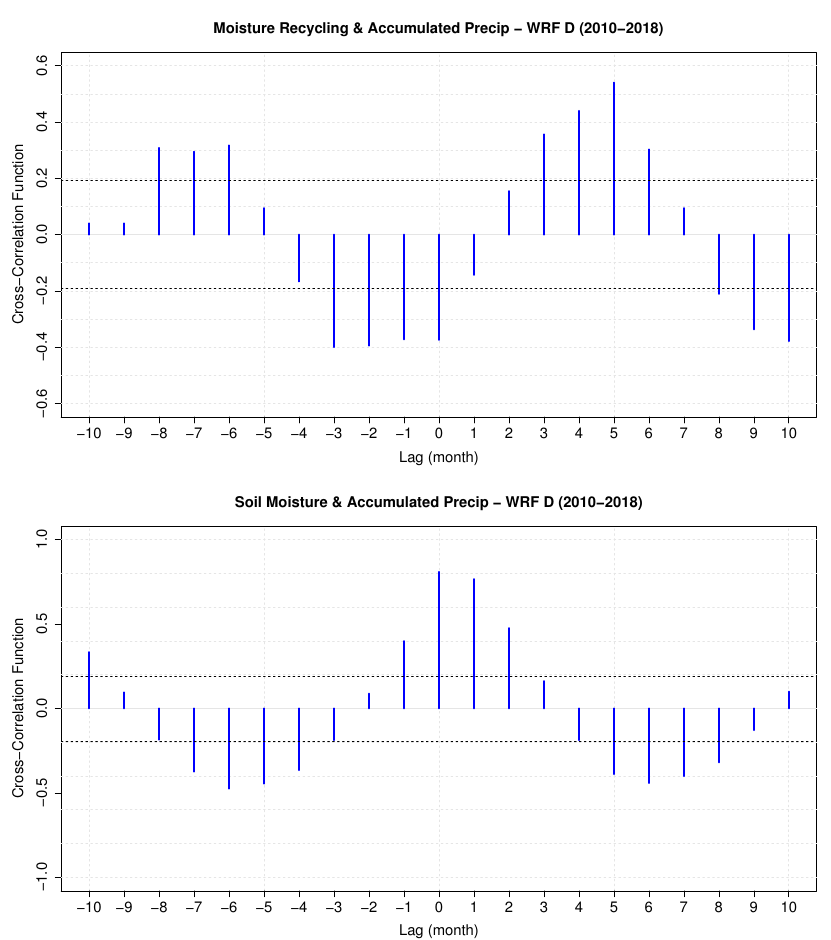
Figure 8. Cross-Correlation Function (CCF) of moisture recycling against precipitation (top) and CCF of soil moisture against precipitation